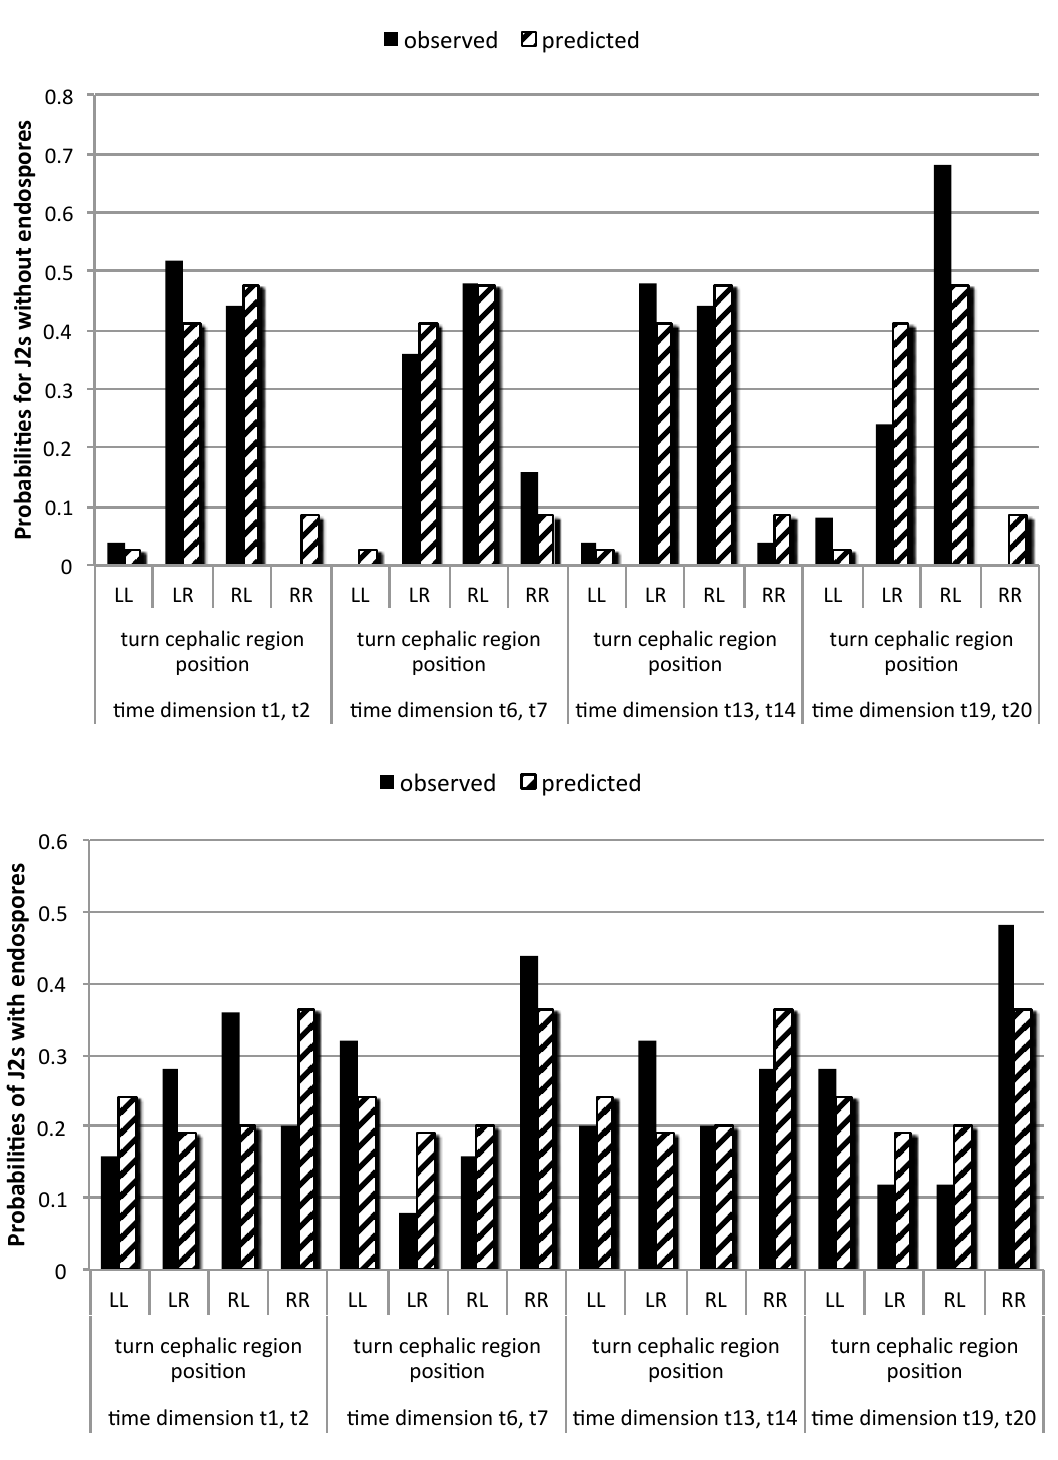
Figure 2. Observed and expected probabilities (at a fixed matrix P 256 ), of unencumbered second-stage Meloidogyne javanica juveniles (J2s) turning in the same or different directions (A), and predicted probabilities (at a fixed matrix Q 256 ), of J2s encumbered with Pasteuria penetrans endospores, turning in the same or different directions